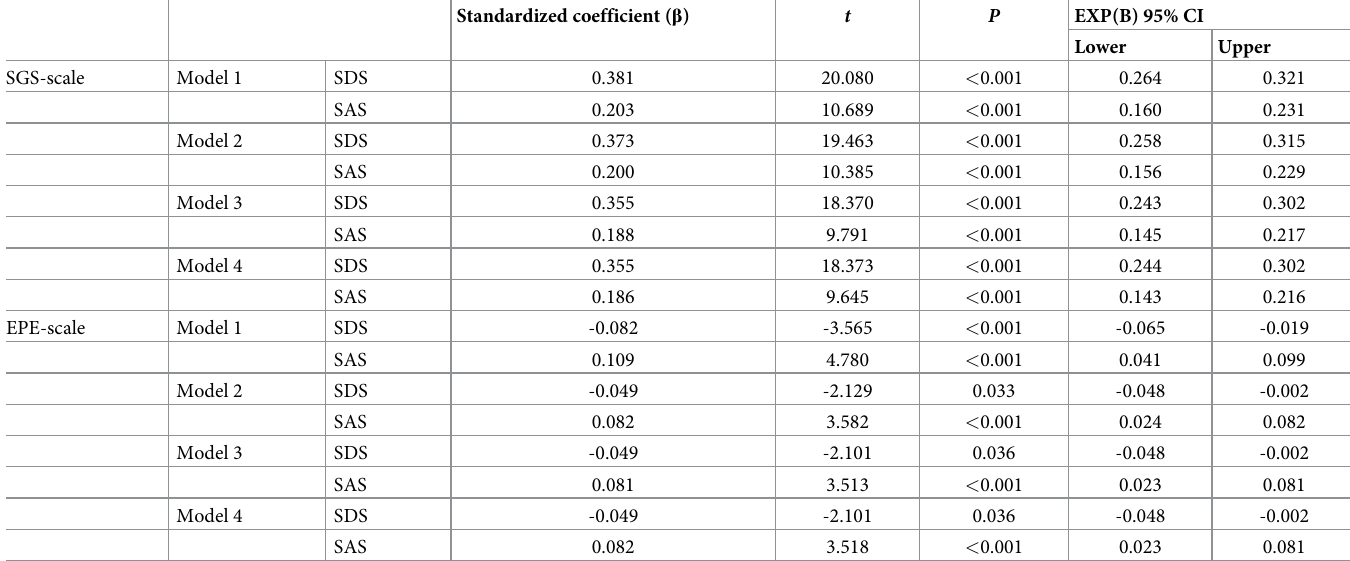
Table 5. Correlations between the social rhythm disruption and psychological impacts as determined by multivariate linear regressive